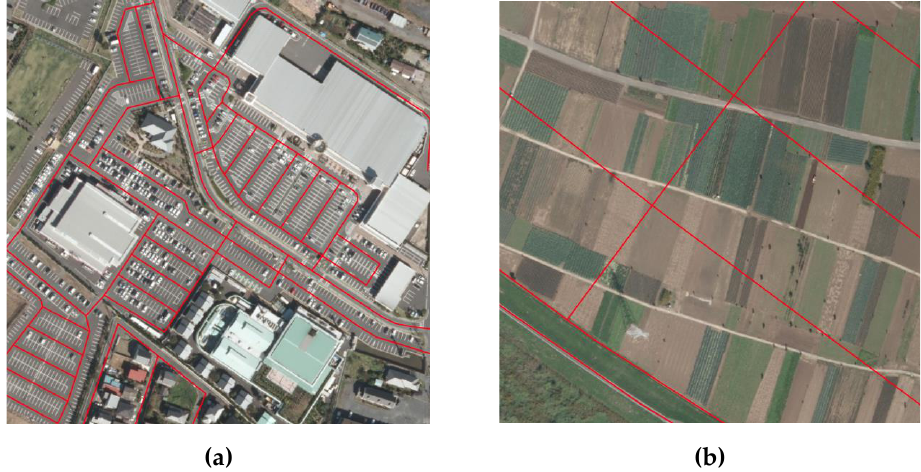
Figure 9. Examples of problems with OSM road vector map: (a) over-acquisition of roads; (b) inconsistency with new-period aerial photo.